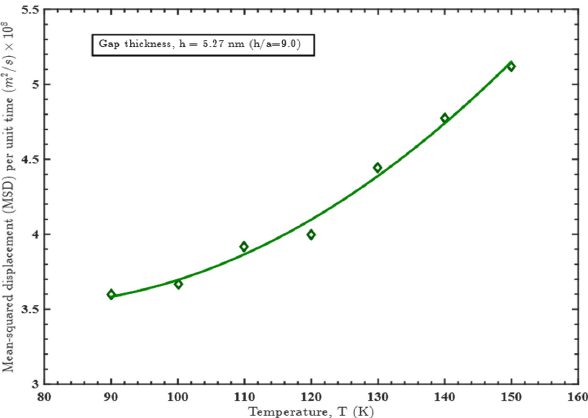
Figure 9. Mean squared displacement of entrapped liquid Ar as a function of temperature.